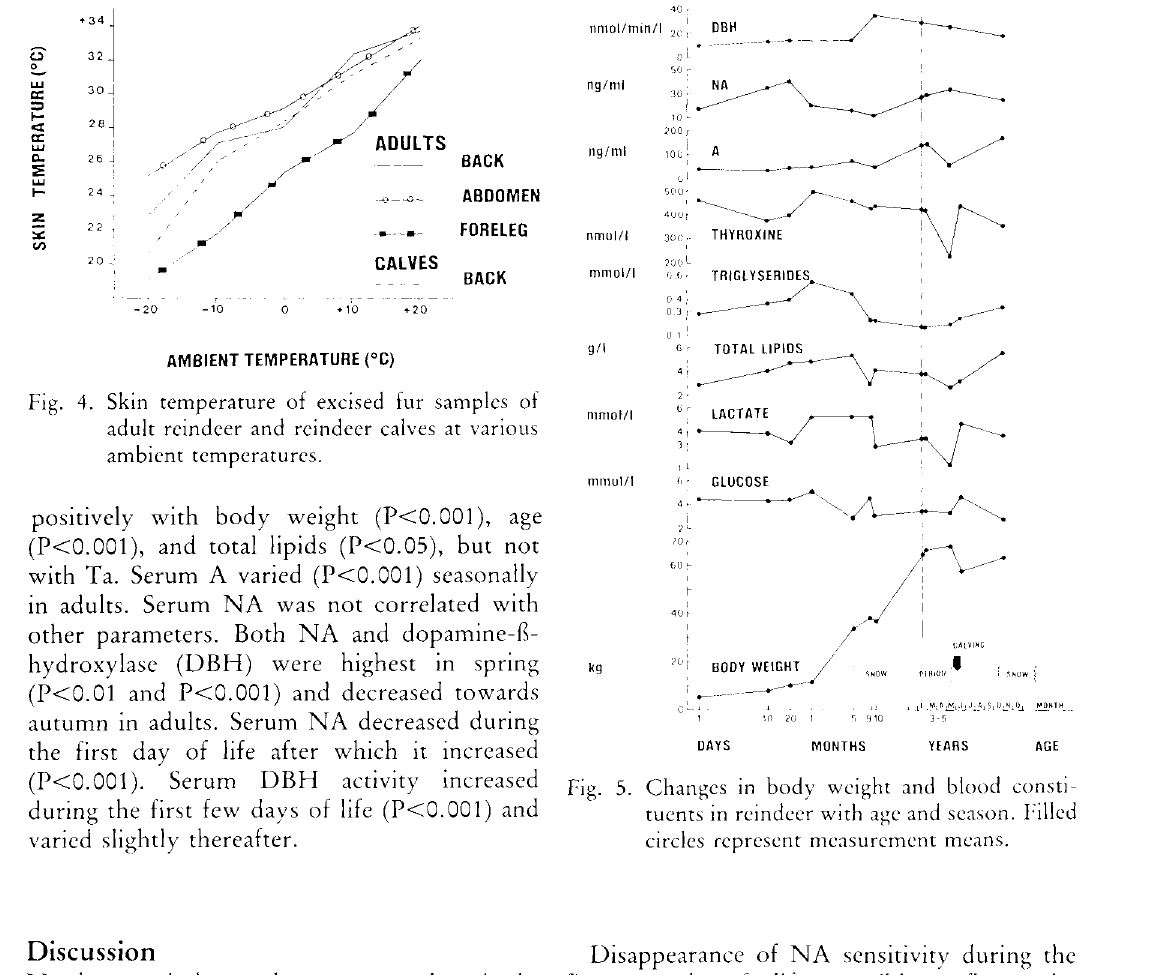
Fig. 4. Skin temperature of excised fur samples of adult reindeer and reindeer calves at various ambient temperatures.